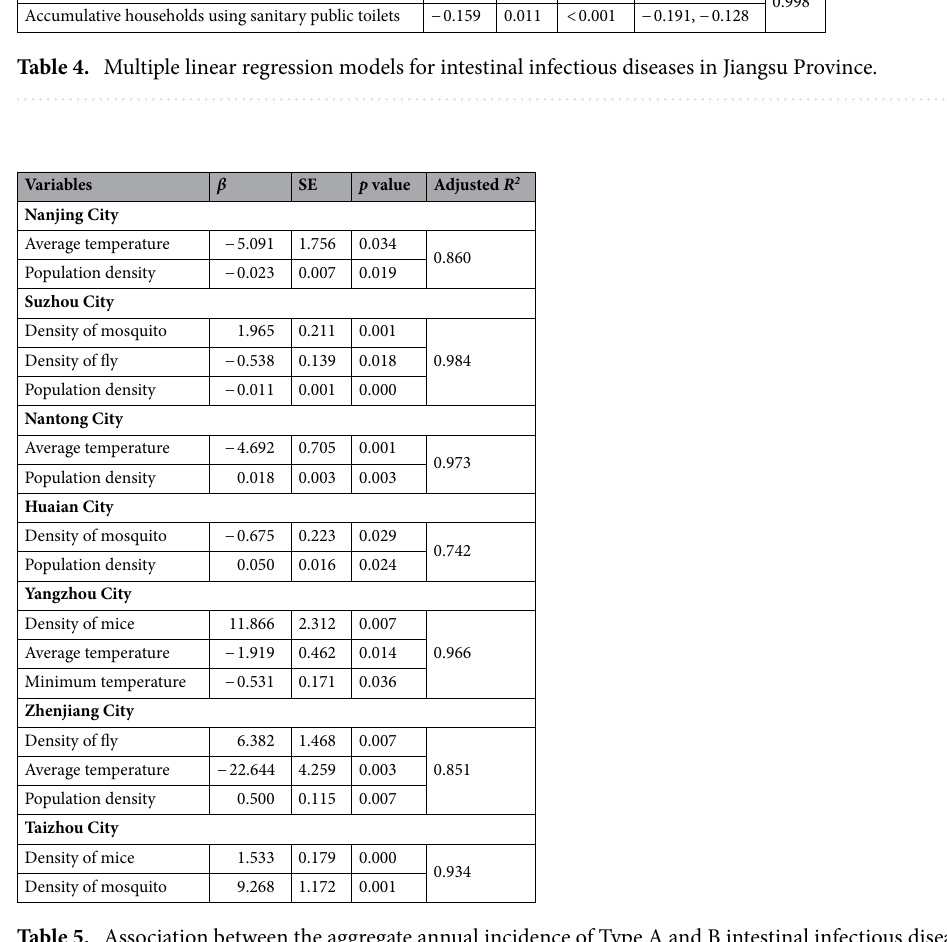
Table 5. Association between the aggregate annual incidence of Type A and B intestinal infectious diseases and various factors in each city. Only significant models with p < 0.05 are shown in the table.